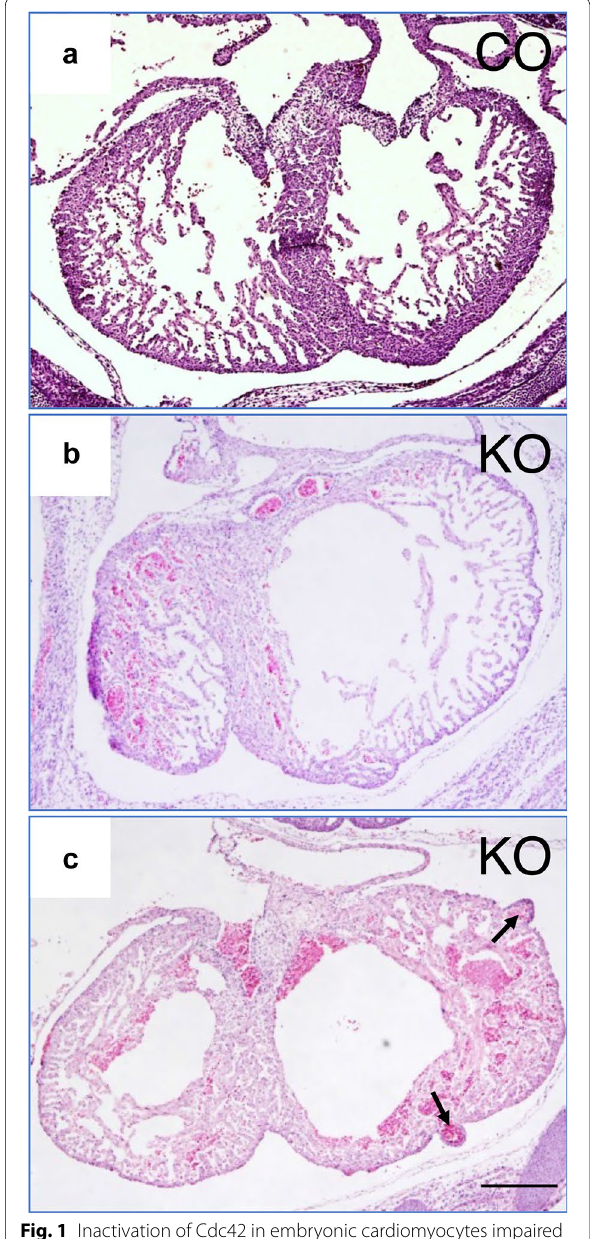
Fig. 1 Inactivation of Cdc42 in embryonic cardiomyocytes impaired right ventricle growth. Histological transverse sections through the hearts from E14.5 control ( a ) and knockout embryos ( b , c ). H&E stain- ing showed a smaller right ventricle in the different section levels of the knockout ( b , c ). Black arrows indicate evaginations in the ventricle wall. Scale bar: 250 μm